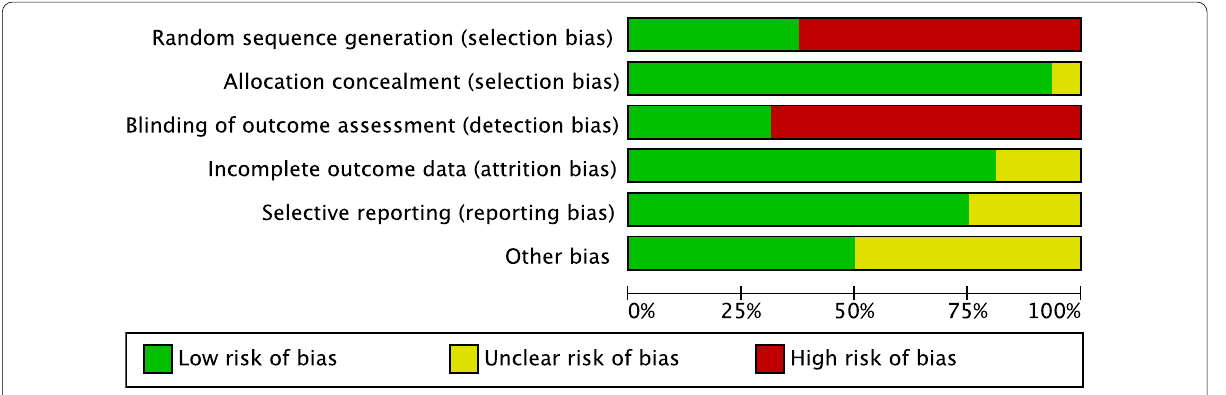
Fig. 2 Methodological quality